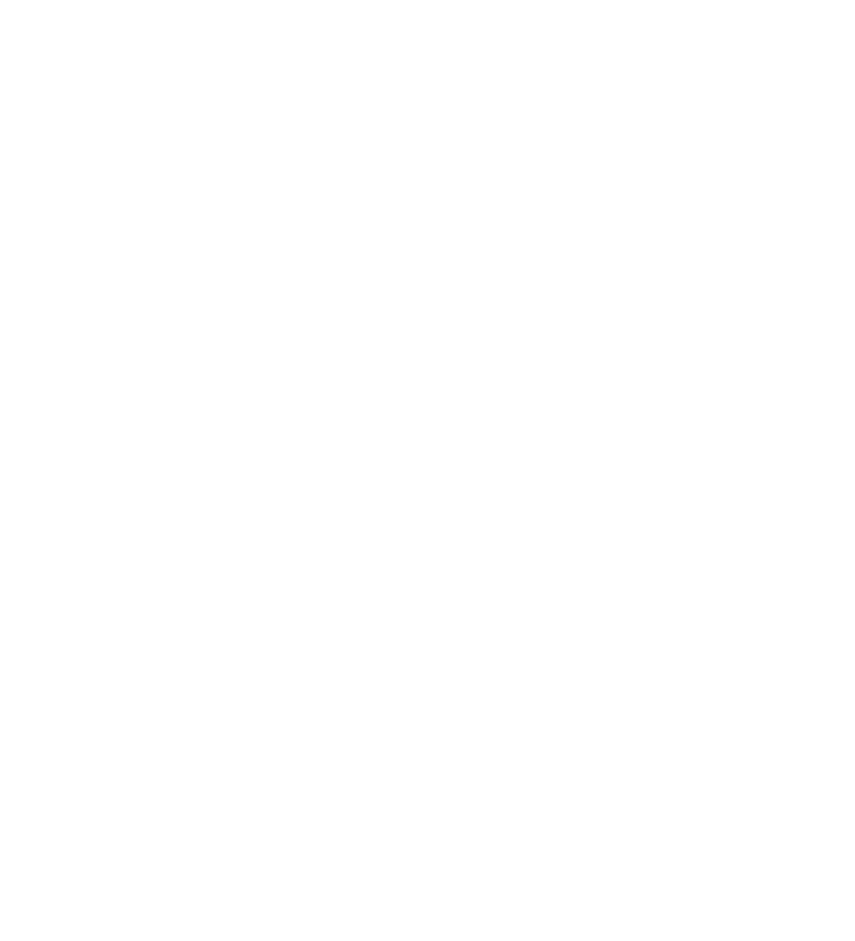
Figure S1 | Comparison of SNP-frequencies to published data (dbSNP). SNP frequencies determined in our study were compared to available SNP data in dbSNP ( n = 153). MAF, minor allele